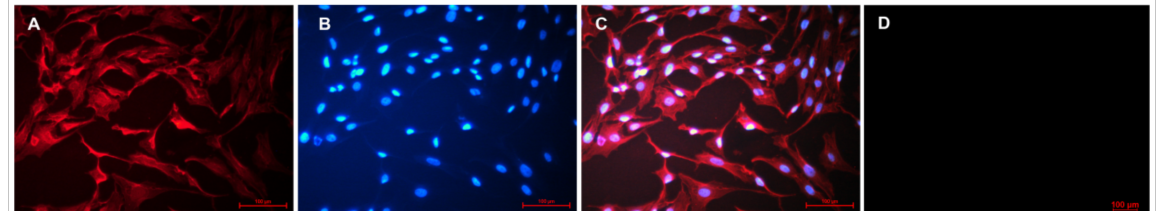
Figure 1. Representative immunofluorescence images of fixed GCs. ( A ) GCs were stained with cy3 to visualize FSHR (shown in red). ( B ) DNA was stained with DAPI (shown in blue). ( C ) Merged image of ( A ) and ( B ). ( D ) Blank control without FSHR antibody staining. The fluorescence in the cells in the same field was observed under a fluorescence inverted microscope under ultraviolet and green excitation light and camera. N =